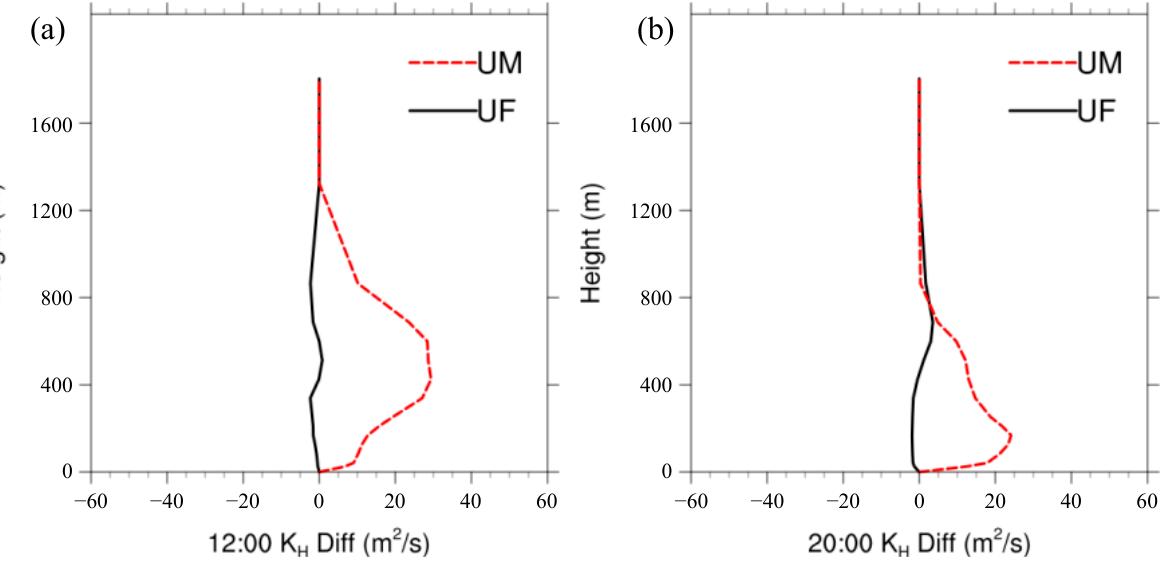
Figure 8. Effects of the high-resolution UF and UM on the vertical distribution of the simulated heat exchange coefficient in the underlying surface layers of the Tianhe District during the daytime (( a ) 12:00 LST) and night-time (( b ) 20:00 LST). The heat exchange was is calculated online with the simulation and outputted by the WRF model.